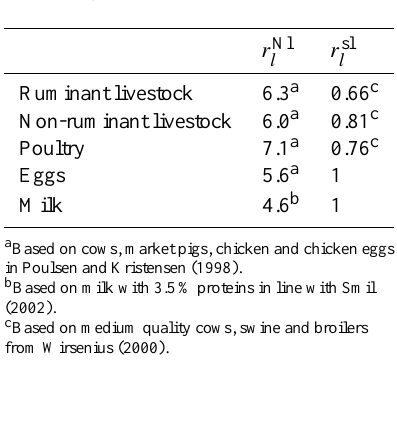
Fig. A1. Modelling N r flows in the livestock sector. Table A5. Estimates of whole body N r content ( r Nl ) in % of dry l matter, and estimates of the ratio between marketable product and whole body weight ( r sl l